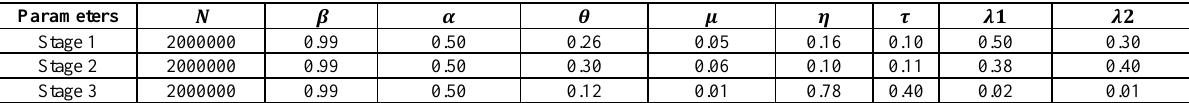
Table 1. Model parameter values at each